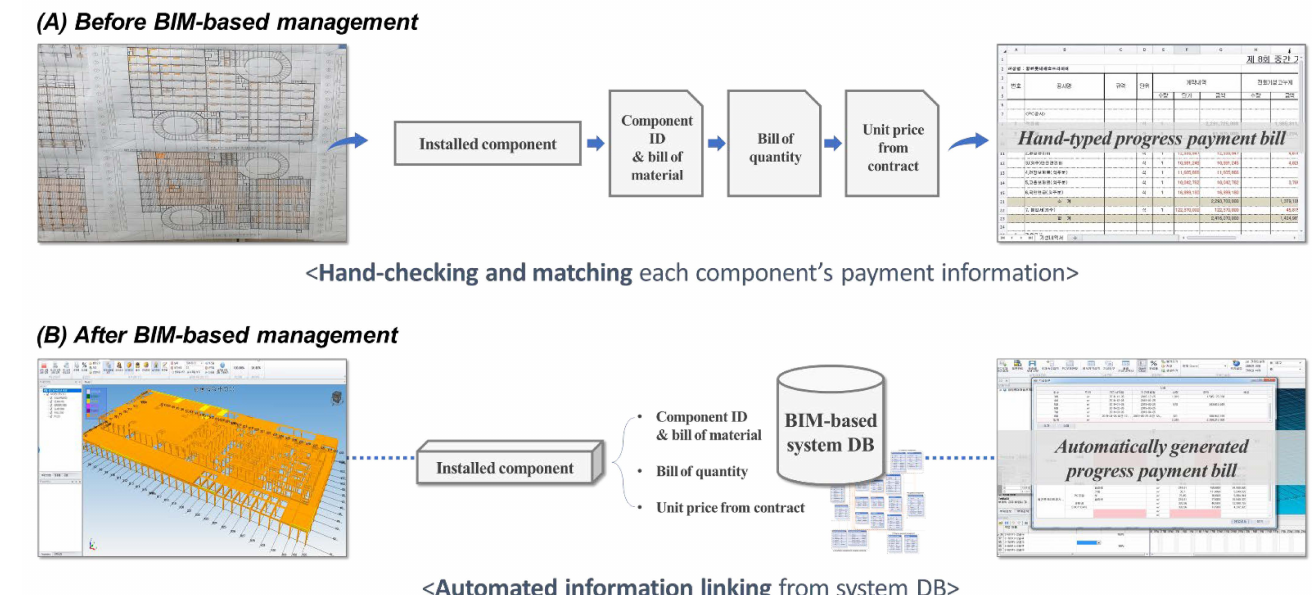
Figure 10. Automatic progress payment management using the BIM-based